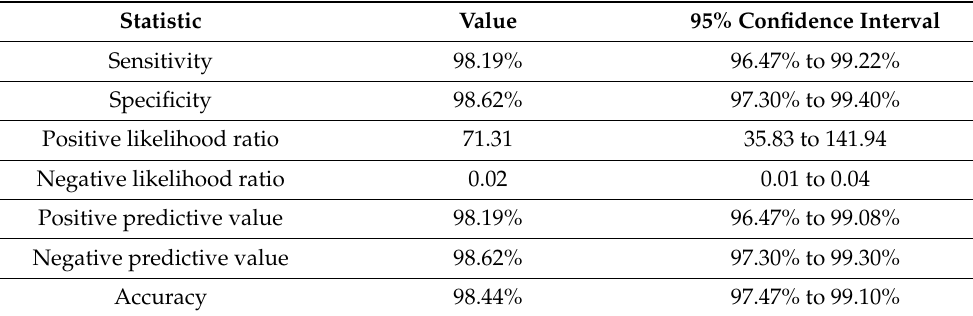
Table 4. Test statistics and confidence intervals regarding the logistic regression.